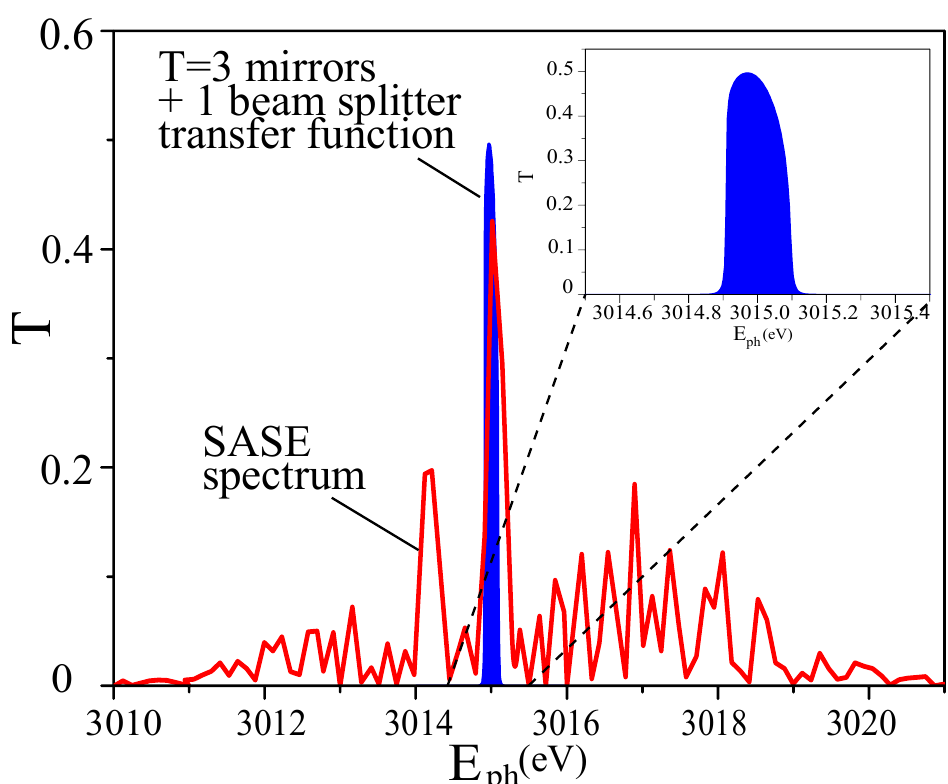
Figure 4. Transfer function T of an optical line made by three diamond mirrors and one beam splitter (in blue) vs. the photon energy for an incidence angle Θ 0 of 3 with respect to the normal. SASE spectrum (in red) in arbitrary units. The reflectivities are simulated with the XOP code [55].